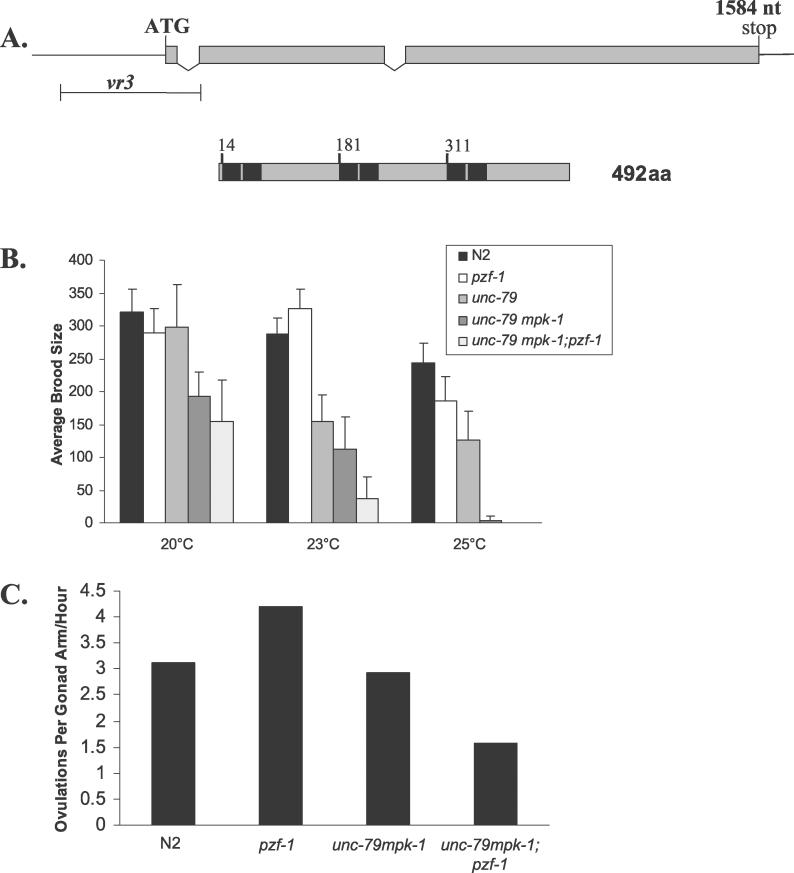

pzf-1 Displays a Reduced Brood Size in the mpk-1 Background(A) Schematic of pzf-1 genomic locus showing location of vr3 deletion (top) and predicted PZF-1 protein (bottom), with predicted C2H2 zinc finger domains in black. Numbers indicate amino acid residue of start of each C2H2 zinc finger pair.(B) Chart of mean live progeny per animal of N2, pzf-1(vr3), unc-79(e1068), unc-79(e1068)mpk-1(ga111), and unc-79(e1068)mpk-1(ga111);pzf-1(vr3) at 20 °C, 23 °C, and 25 °C. The total number of progeny from six to 24 hermaphrodites was counted for each temperature. Error bars indicate standard deviation.(C) Ovulations/gonad arm/hour of N2, pzf-1(vr3), unc-79(e1068)mpk-1(ga111), and unc-79(e1068)mpk-1(ga111);pzf-1(vr3). The unc-79(e1068)mpk-1(ga111) strain showed a statistically significant difference from unc-79(e1068)mpk-1(ga111);pzf-1(vr3). Because ovulation rates were determined on groups of N2 and pzf-1(vr3) worms, standard deviation was not calculated.